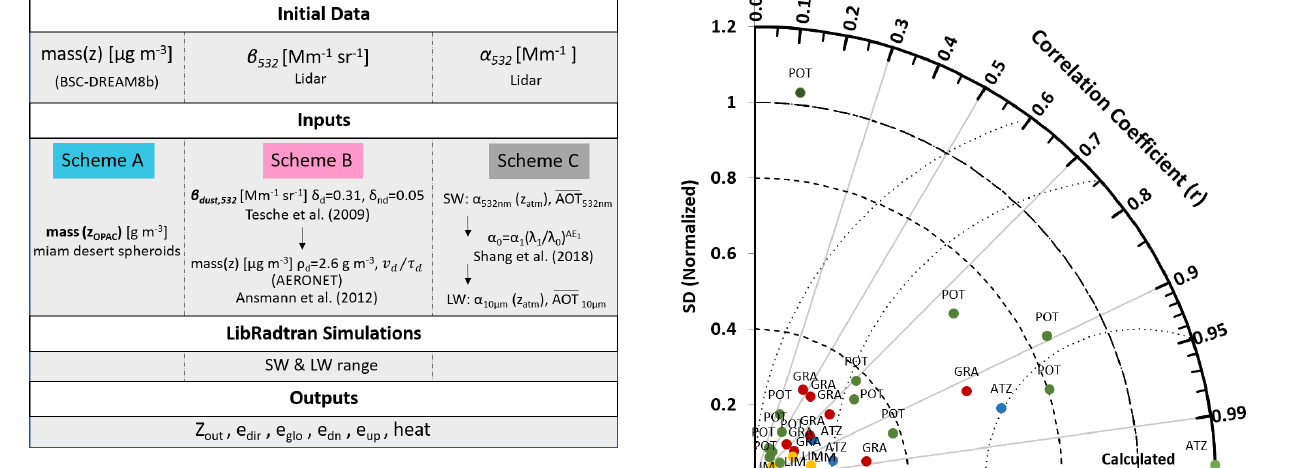
Figure 2. Flowchart of the three schemes used to retrieve simula- tions of irradiances using the libRadtran software package.